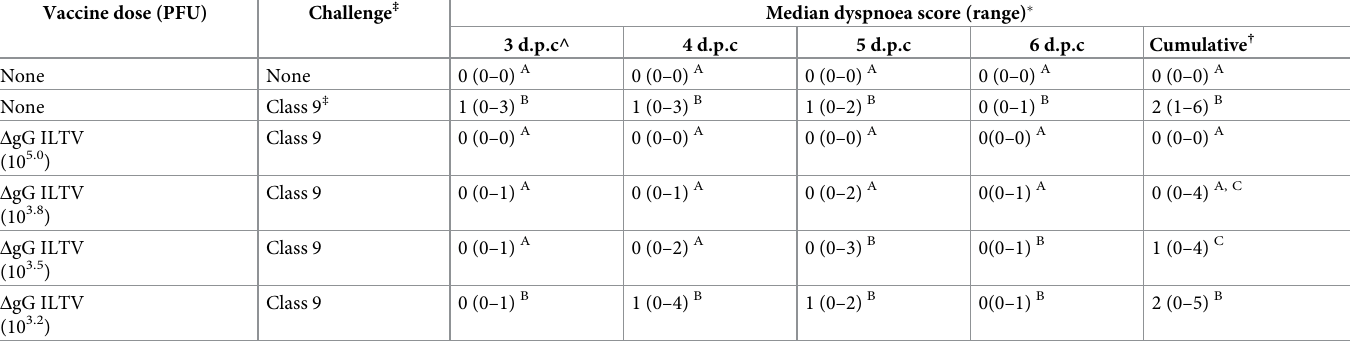
Table 3. Scores for dyspnoea on days 3 to 6 after challenge in unvaccinated birds and in birds vaccinated with different doses of Δ gG ILTV vaccine administered via eye-drop. Vaccine dose (PFU)